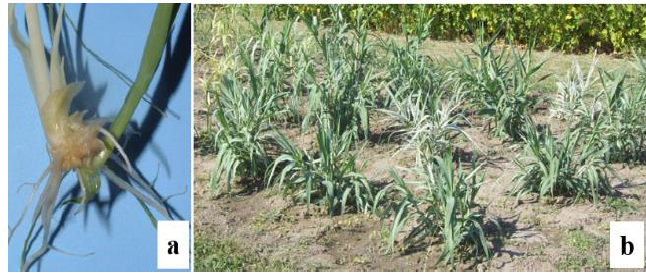
Figure 2. Varieties of striped giant reed derived by somatic embryogenesis at University of Debrecen (Hungary – July 2014) Source: photos by Gabriella